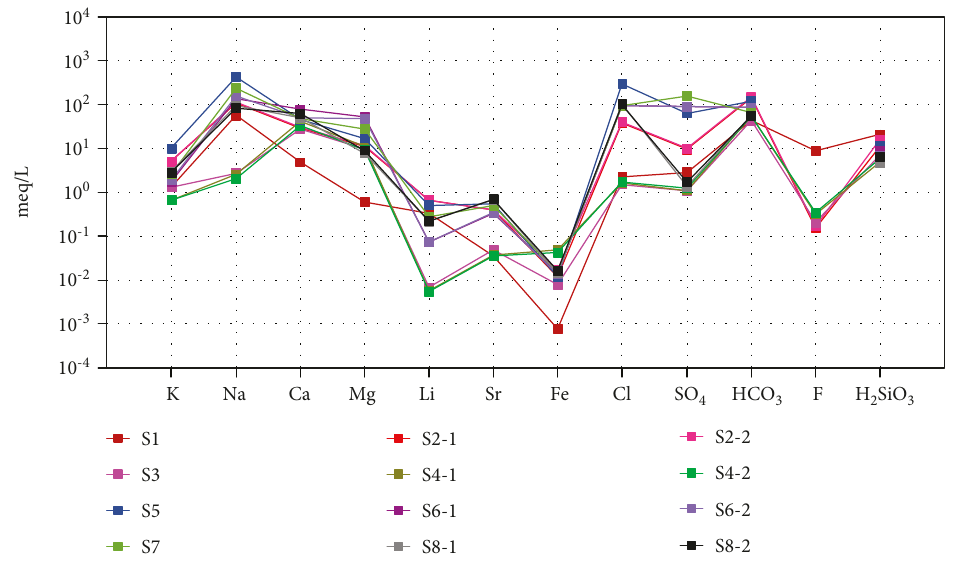
Figure 3: Modi fi ed Schoeller diagram showing major ion constituents of the hot spring water samples in the Simao